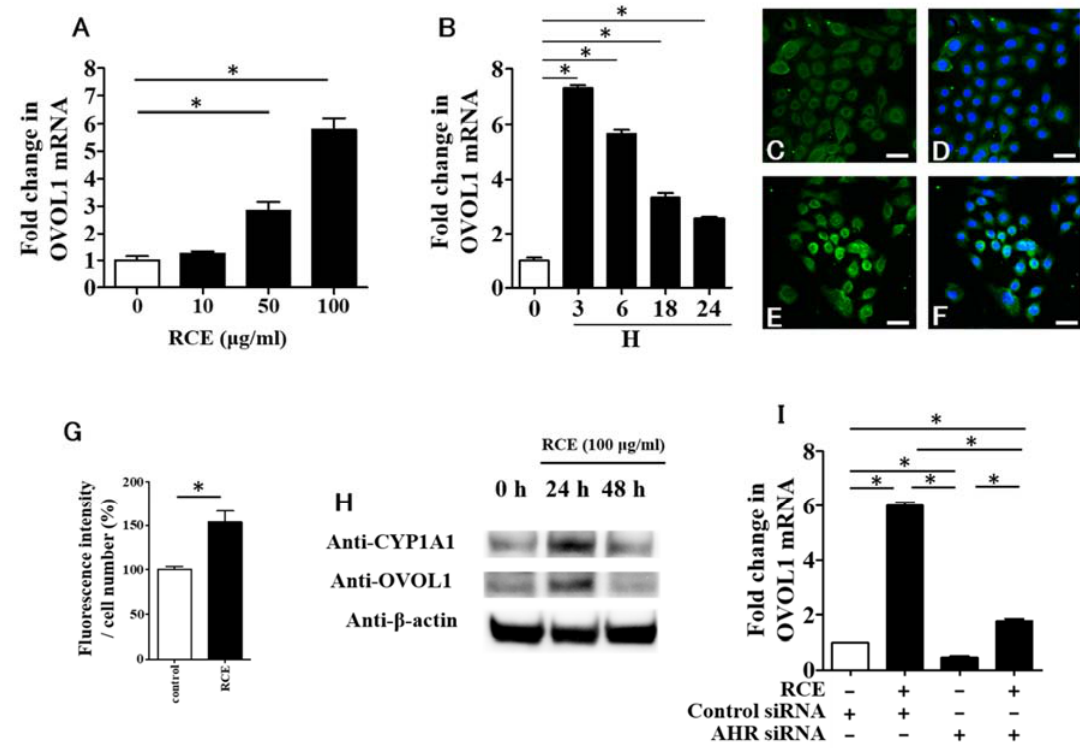
Figure 4. ( A ) RCE upregulates OVO ‐ like 1 ( OVOL1 ) expression; ( B ) RCE (100 μ g/mL) upregulates OVOL1 expression as early as 3 h after the treatment; ( C , D ) OVOL1 is mainly localized in the cytoplasm of keratinocytes treated with DMSO control; ( D ) Nuclei are stained with DAPI; ( E , F ) Nuclear translocation of OVOL1 is observed in keratinocytes treated with RCE (100 μ g/mL); ( F ) Nuclei are stained with DAPI; Scale bar: 25 μ m; ( G ) Fluorescence intensity of OVOL1 is enhanced in keratinocytes treated with RCE (100 μ g/mL); ( H ) Upregulation of OVOL1 as well as CYP1A1 protein by RCE (100 μ g/mL) is shown by Western blot analysis; ( I ) RCE ‐ mediated OVOL1 expression is canceled in AHR ‐ knockdown keratinocytes. White bar expresses DMSO control. Data are expressed as mean ± SEM ( n = 3). *: p < 0.05.